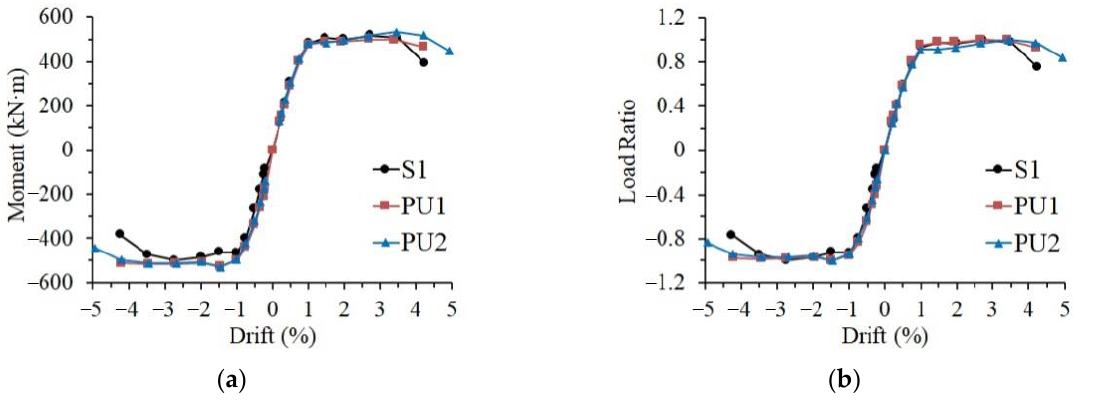
Figure 8. Skeleton curves of the test specimens. ( a ) Actual curve, ( b ) normalized curve.